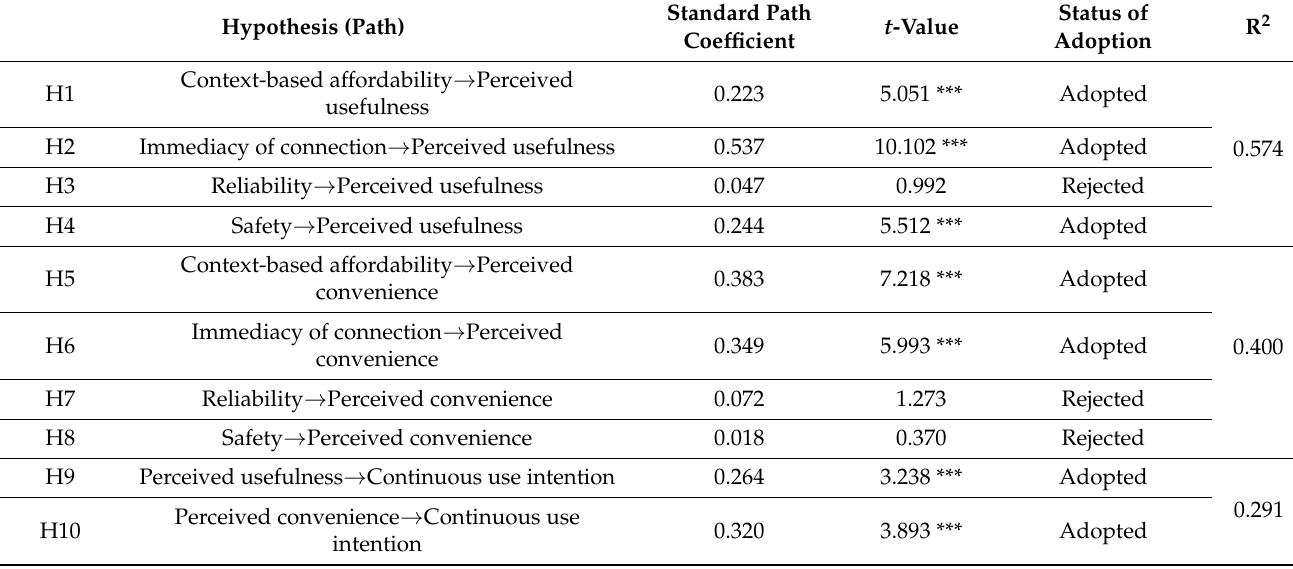
Table 6. Results of hypothesis